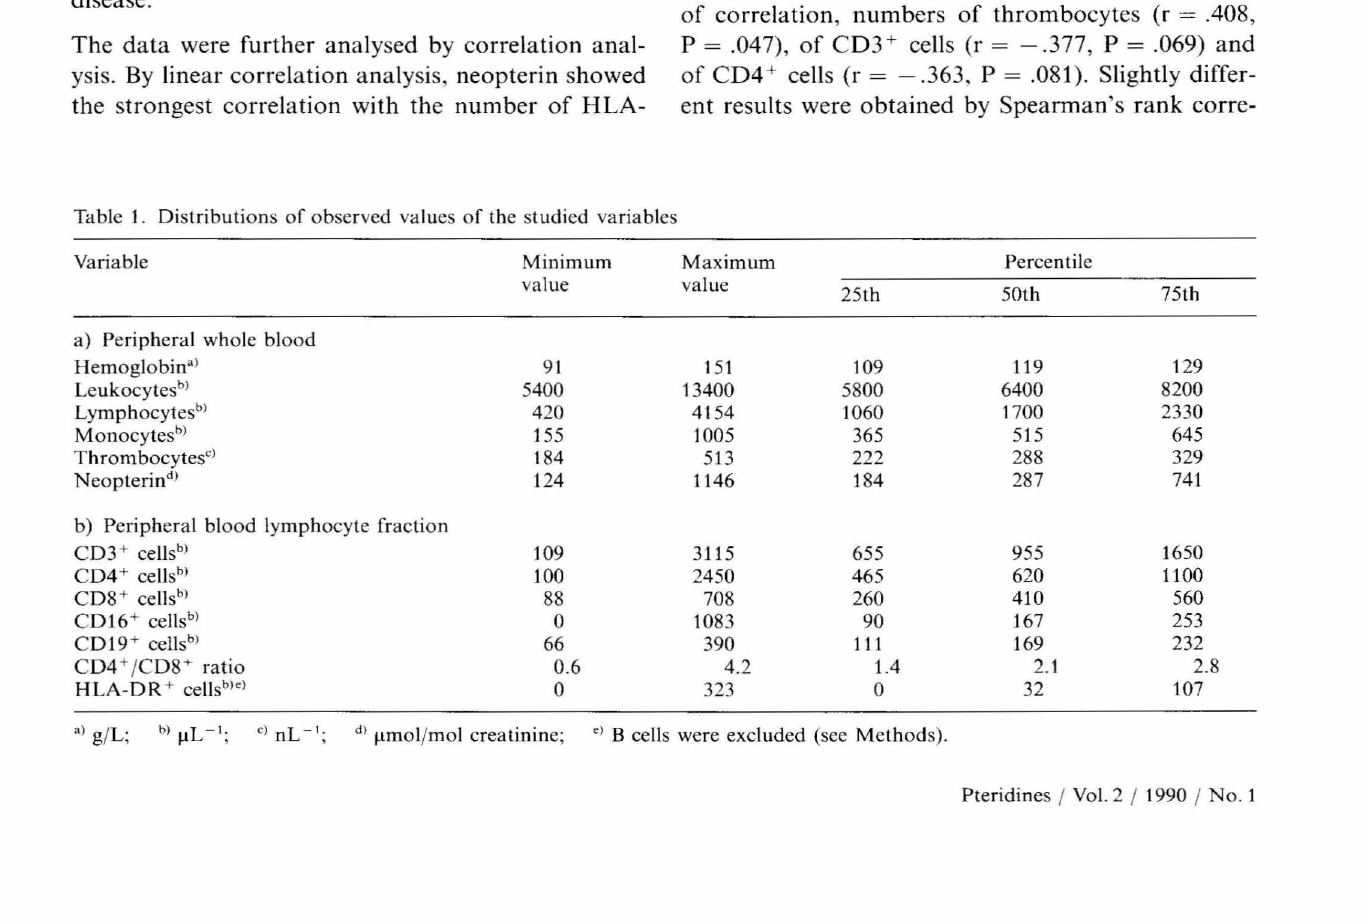
Table 1. Distributions of observed values of the studied variables Variable